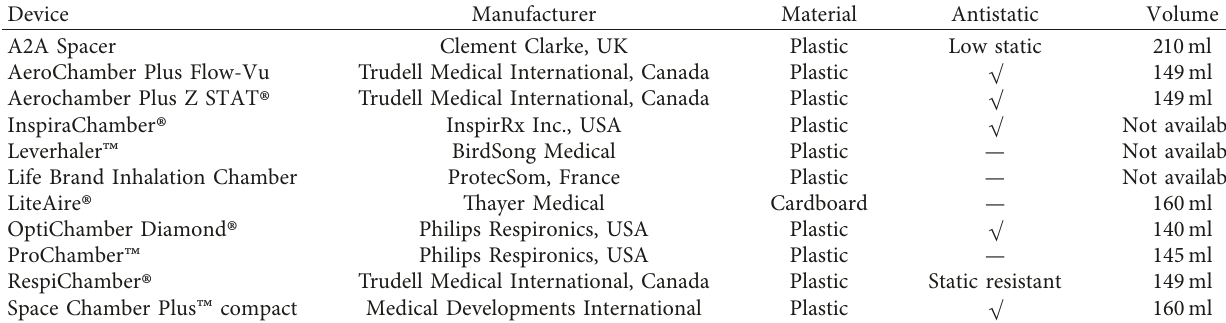
Table 1: Valved holding chambers available in